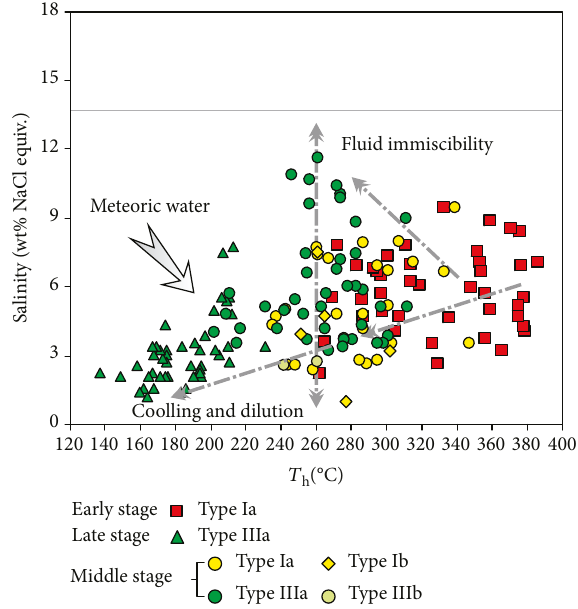
Figure 11: Plots of homogenization temperature ( T di ff erent types of FIs from the Xiejiagou deposit.